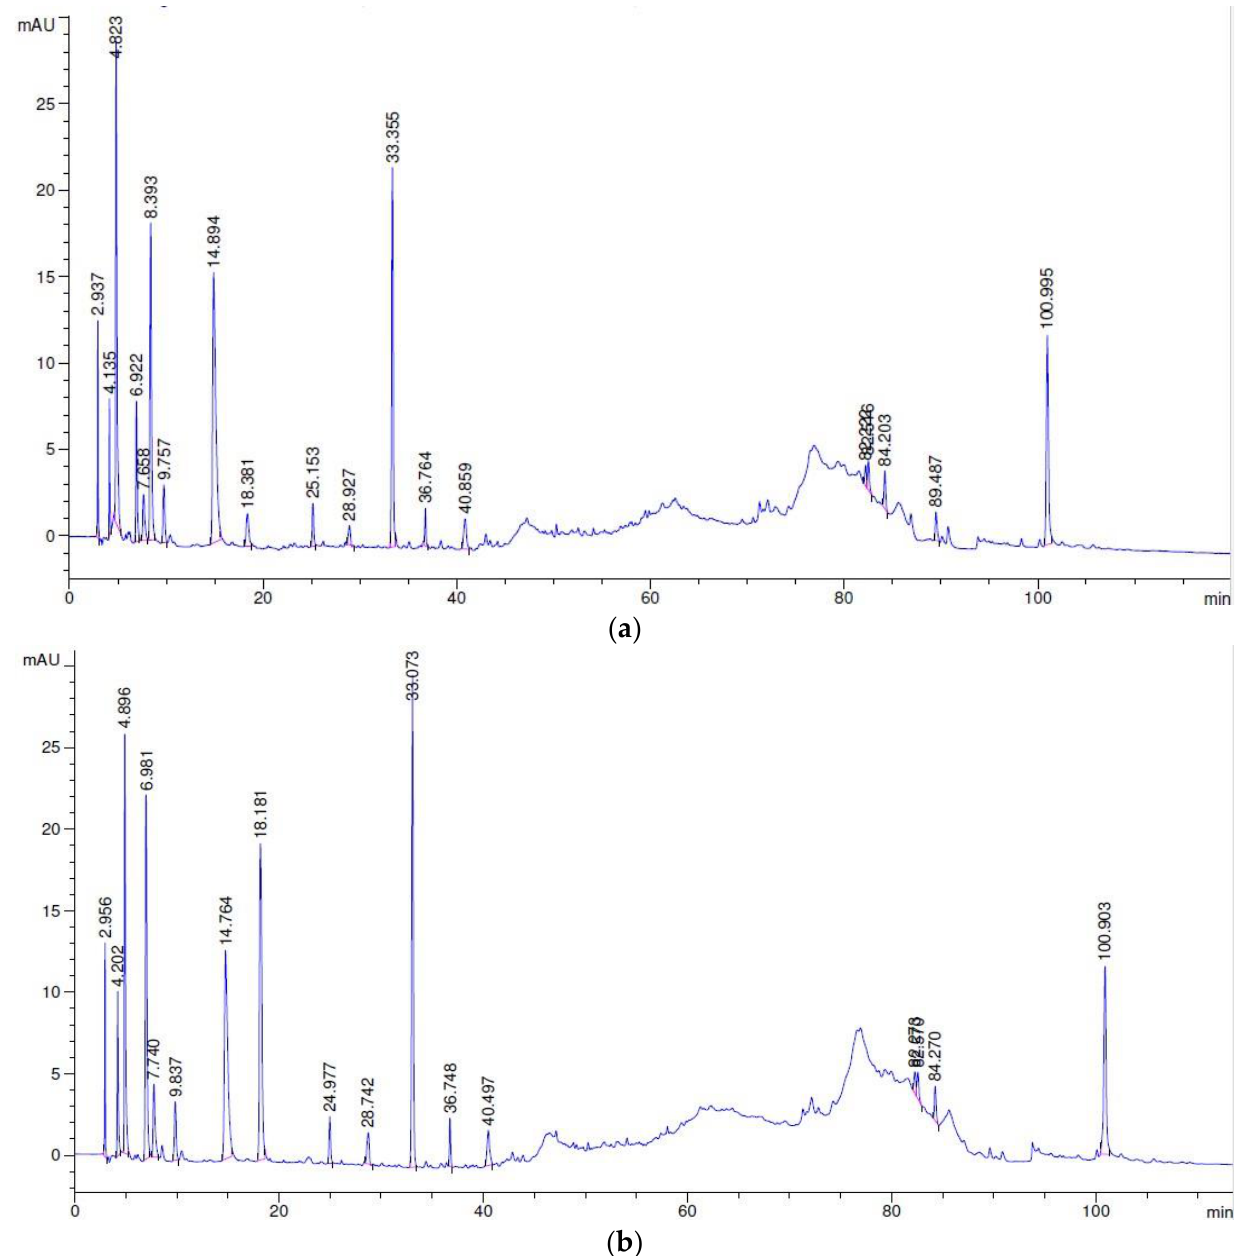
Figure 6. RP-HPLC profiles (A220) of the soluble N fractions of the cheeses: ( a ) control sample, day 3 and ( b ) HPP-treated sample, day 3.